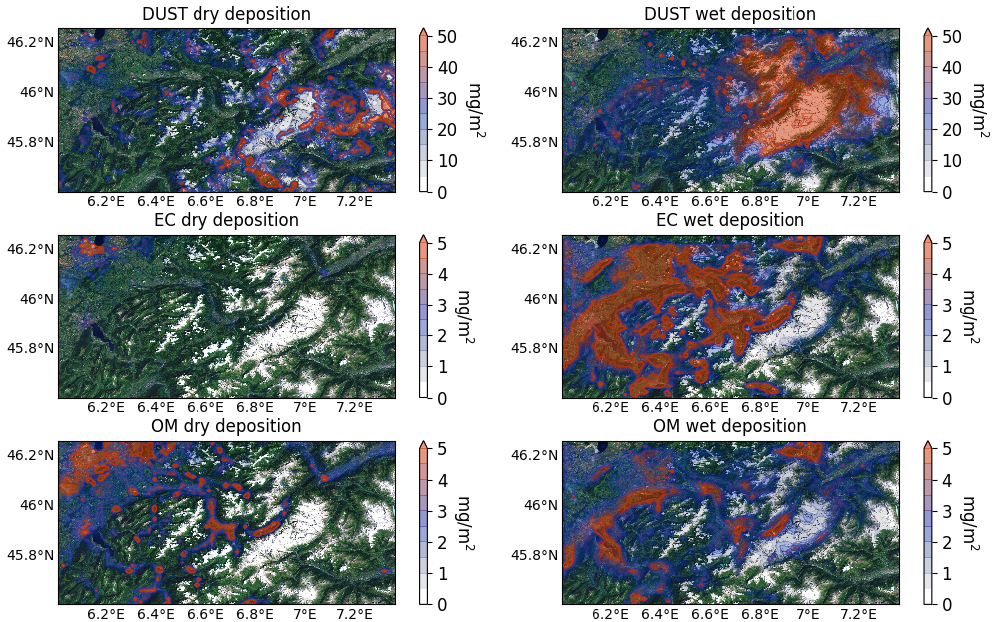
Figure 14. Wet and dry deposition maps at 1 ⁄ 90 ◦ resolution (ARV0011) cumulated over the 15 November to 20 December period for EC, OM and